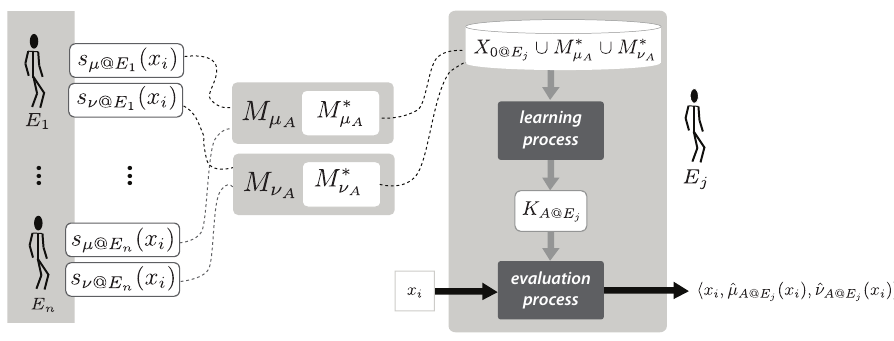
⊆ M µ ⊆ M ν and M ∗ ν along A A A A about the (collection A of) j